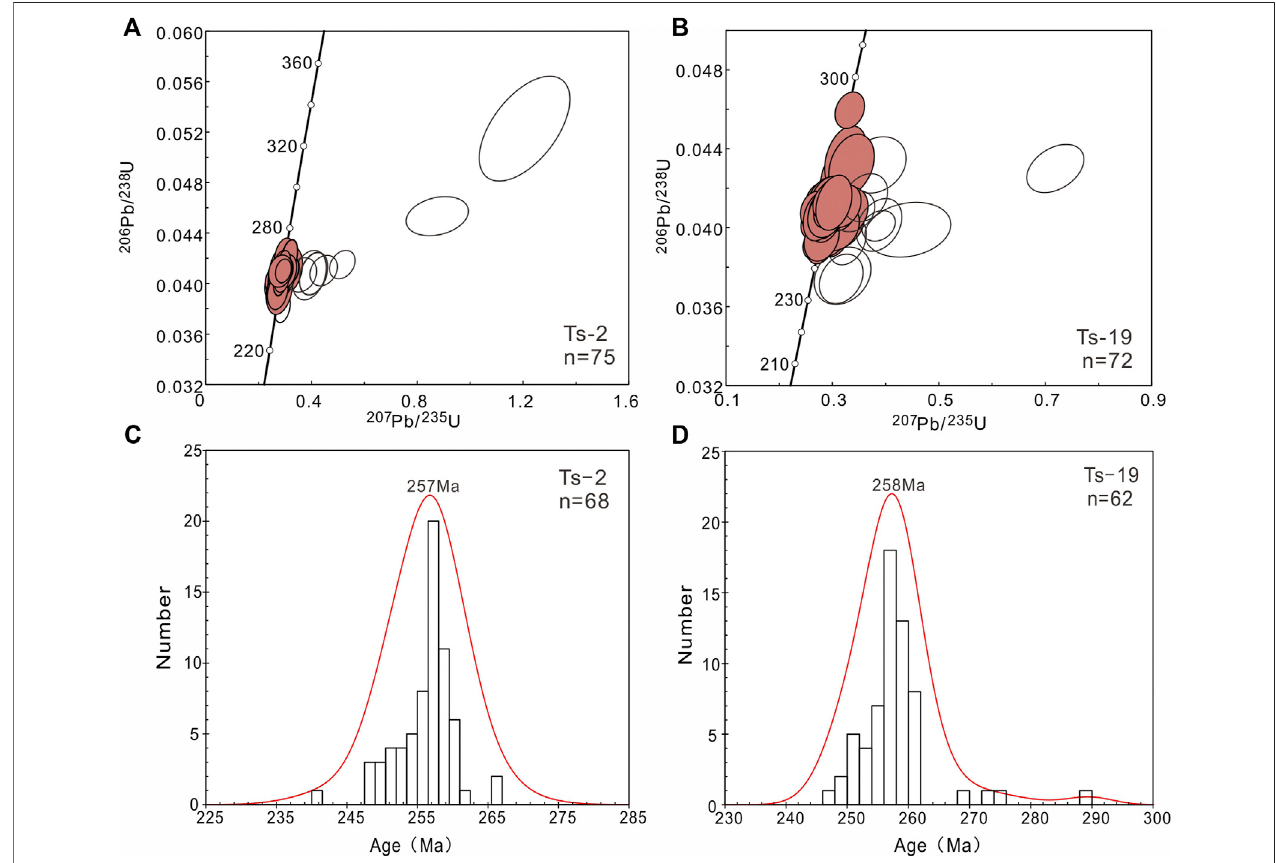
FIGURE 7 | (A,B) U-Pb concordia plots for detrital zircons at Dengchuan. (C,D) Histograms and probability curves for detrital zircon ages at Dengchuan.